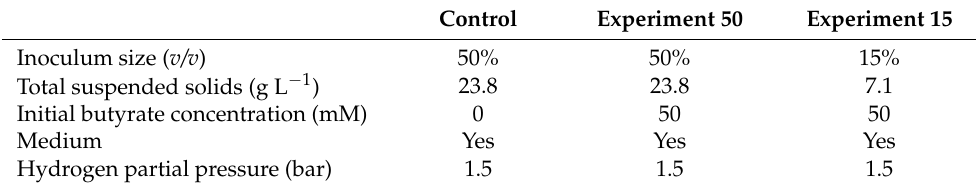
Table 1. Experimental conditions for the 1 L Schott bottle